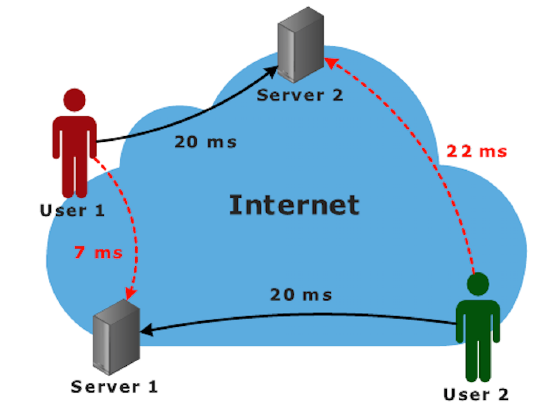
Figure 2. An Example of QoS Utility-based Model